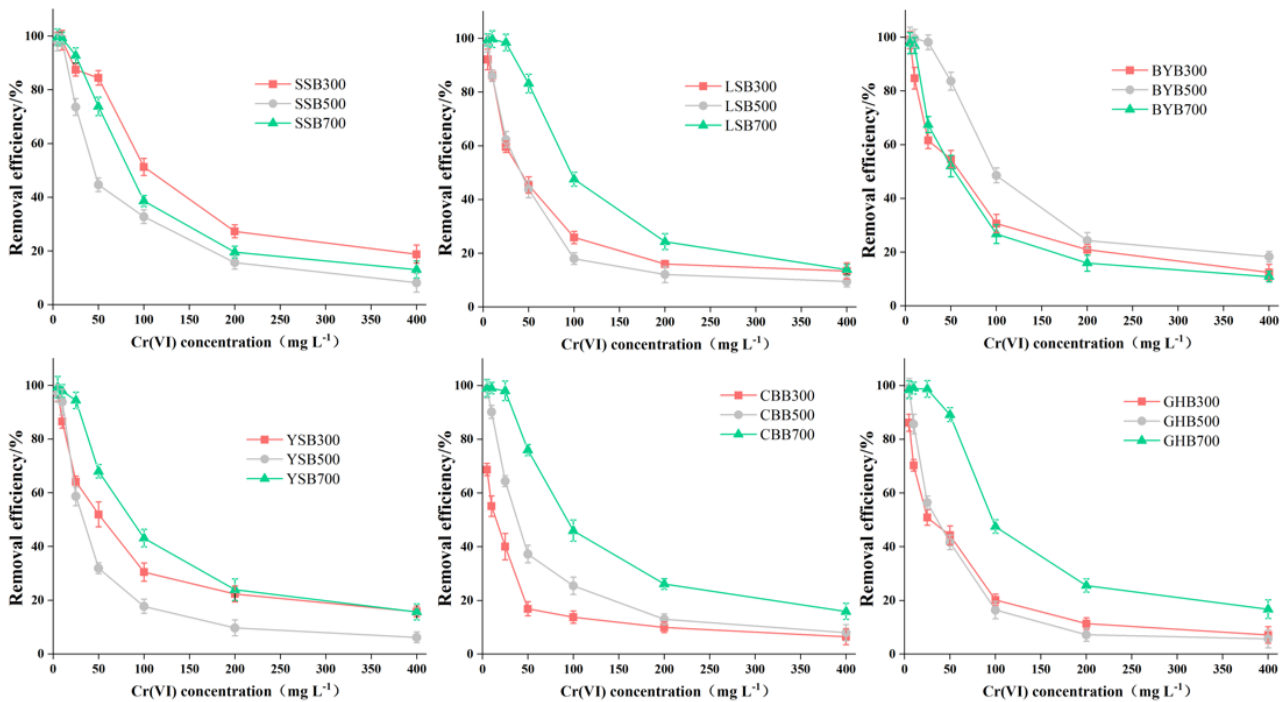
Figure 5. Relationship between initial concentration and Cr (VI) removal efficiency (pH: 2; dosage of biochar: 1.2 g · L − 1 ; reaction time: 1440 min).